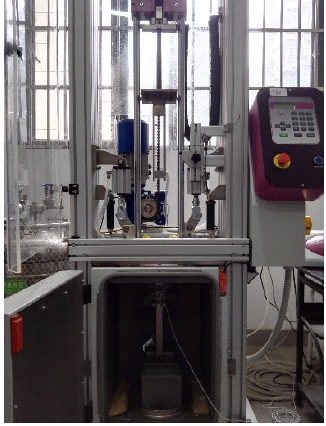
Figure 2. Instron drop-weight impact system.